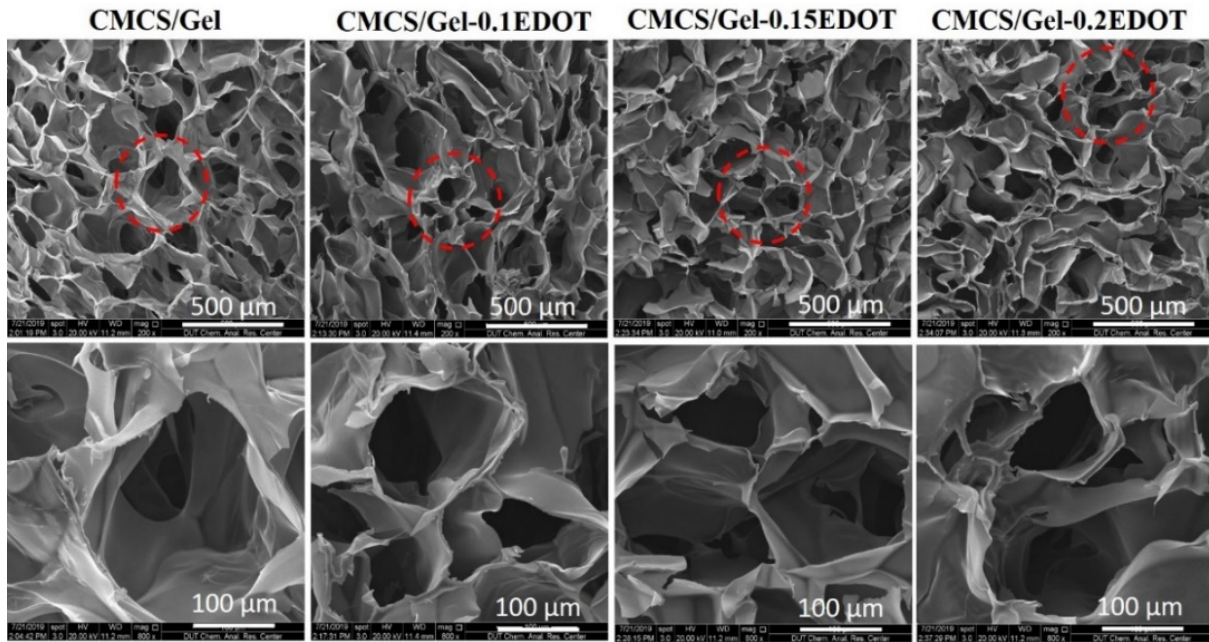
Figure 2. FTIR spectrogram of PEDOT nanoparticles, CMCS/Gel and CMCS/Gel-PEDOT hydrogels.